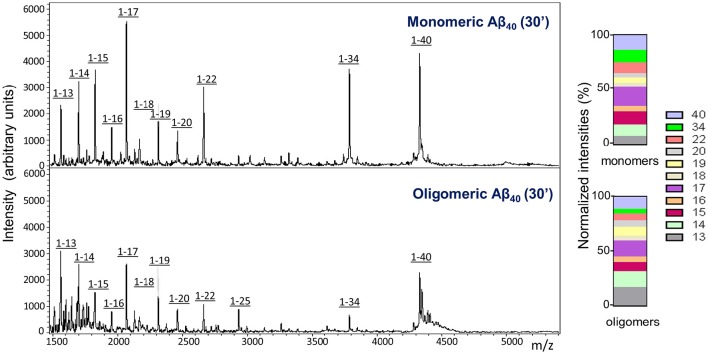
Comparative analysis of Aβ species cleared to the CSF after intracerebral injection of monomeric and oligomeric Aβ1-40. MALDI-ToF spectra and normalized ion counts on CSF collected 30 min after intracerebral injection of comparable amounts of monomeric (top panel) and oligomeric (bottom panel) Aβ1-40 immunoprecipitated with anti-Aβ monoclonal antibody 6E10. For the immunoprecipitation, CSF was pooled from 4 mice injected under the same experimental conditions. Data are representative of 2 independent experiments (n = 8) spotted in duplicate in the mass spectrometer aluminum plates.